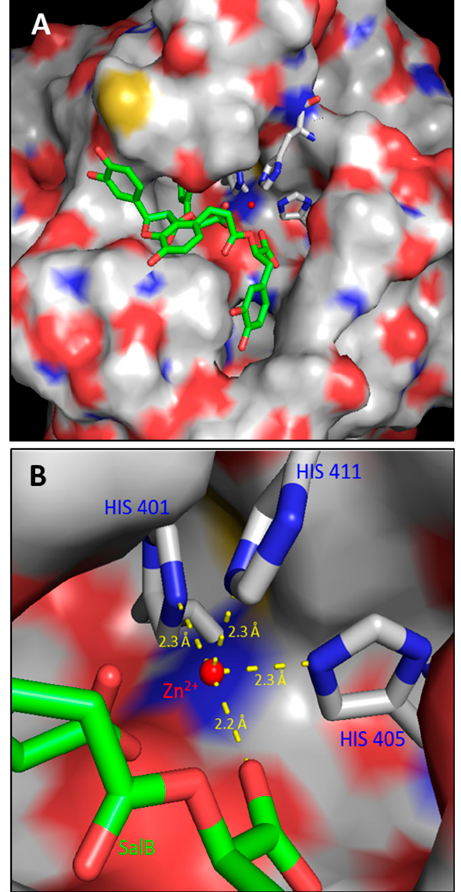
Figure 2. Molecular Docking analysis of the interaction between SalB and MMP-9. ( A ) SalB ability to approach the MMP-9 catalytic pocket. ( B ) Molecular docking of SalB in the catalytic domain of MMP-9 (PDB code: 1GKC). SalB seems able to interact with the catalytic Zn 2+ ion which is coordi- nated by three histidines (HIS401, HIS405, HIS411). The analysis specifically suggests the existence of a coordinated bond between the catalytic Zn 2+ atom and a carboxyl oxygen of SalB structure.